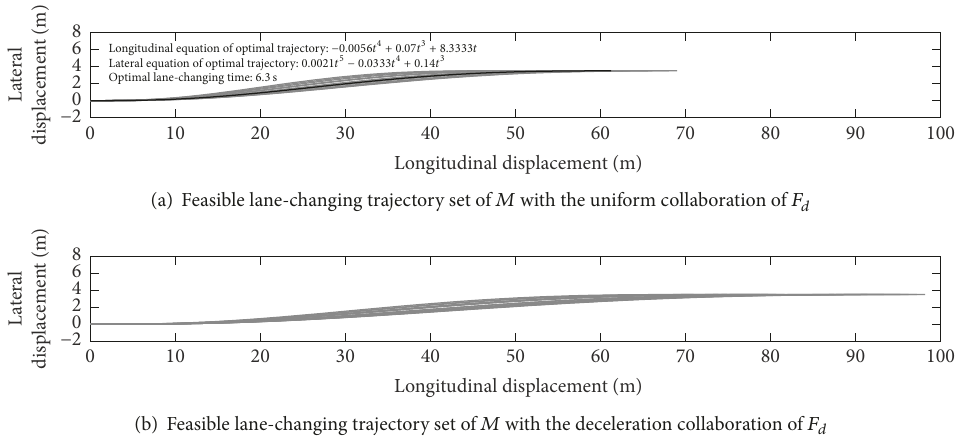
Figure 11: The lane-changing trajectory set of 𝑀 with both the uniform collaboration and deceleration coordination of 𝐹 𝑑 .